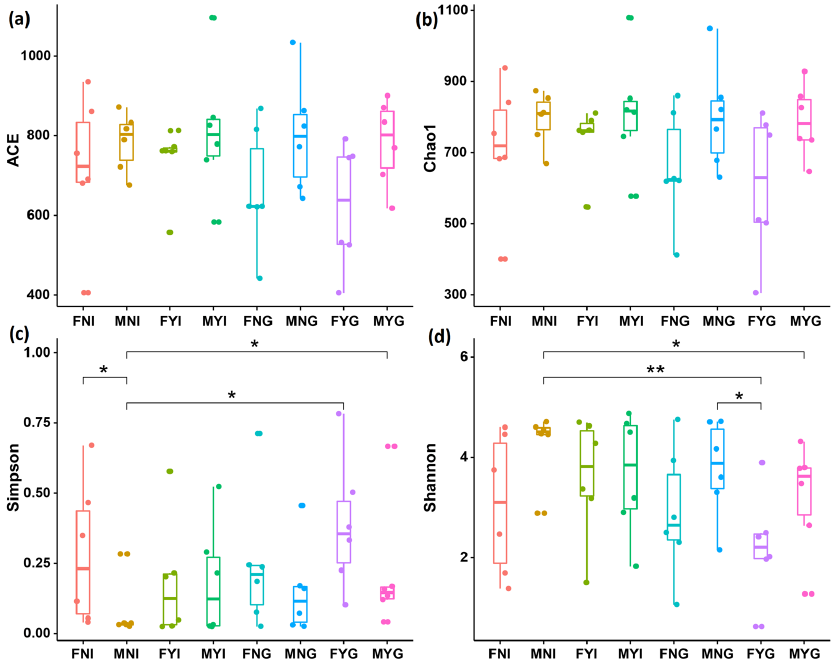
Figure 3. Microbial diversity indices in the intestine and gill microbial samples of dwarf-form populations of Sthenoteuthis oualaniensis . ( a ) Observed, ( b ) Chao1 indices, ( c ) Simpson indices, and ( d ) Shannon indices. FNI: intestine samples of females with immature gonads, MNI: intestine samples of males with immature gonads, FYI: intestine samples of females at sexual maturity, MYI: intestine samples of males at sexual maturity; FNG: gill samples of females with immature gonads, MNG: gill samples of males with immature gonads, FYG: gill samples of females at sexual maturity, and MYG: gill samples of males at sexual maturity. * Indicates the significant difference between two samples ( p < 0.05) and ** indicates the extremely significant difference between two samples ( p < 0.01).